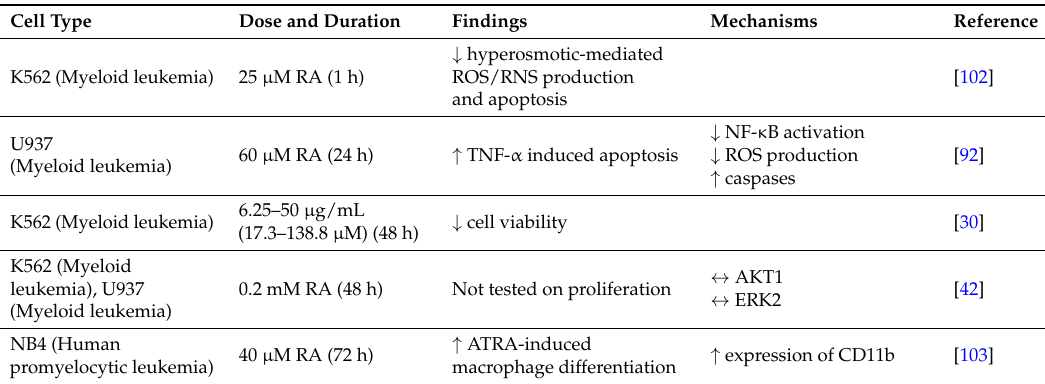
Table 15. Anticancer effects of Rosmarinic Acid (RA). In vitro studies: